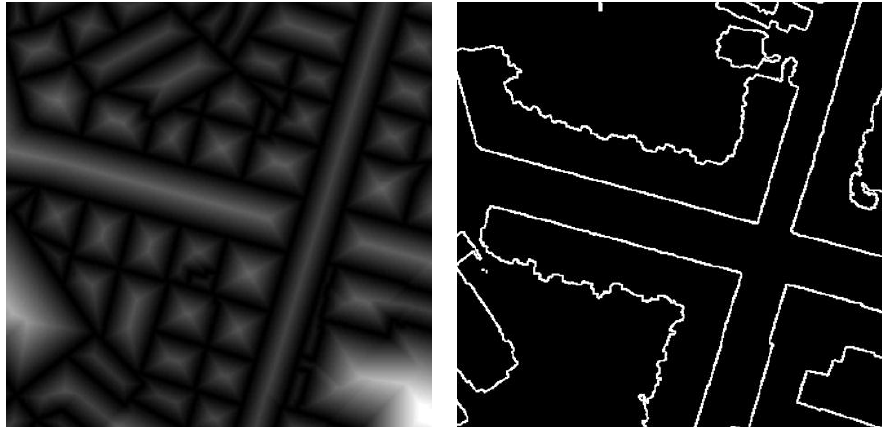
Figure 8. Cadastral raster image in the format of a computed distance transform image (left) and the edges of the segmented image (right) , both used as an input to the Chamfer-match after Borgefors